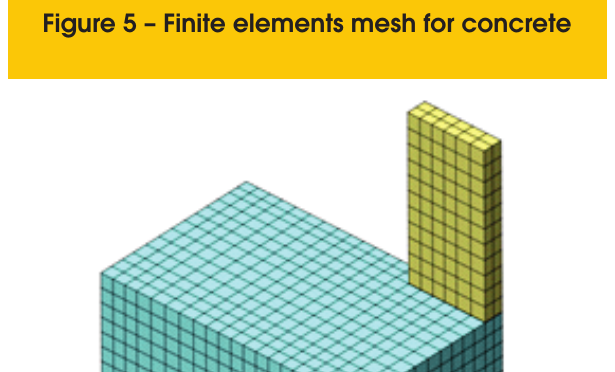
Figure 5 – Finite elements mesh for concrete